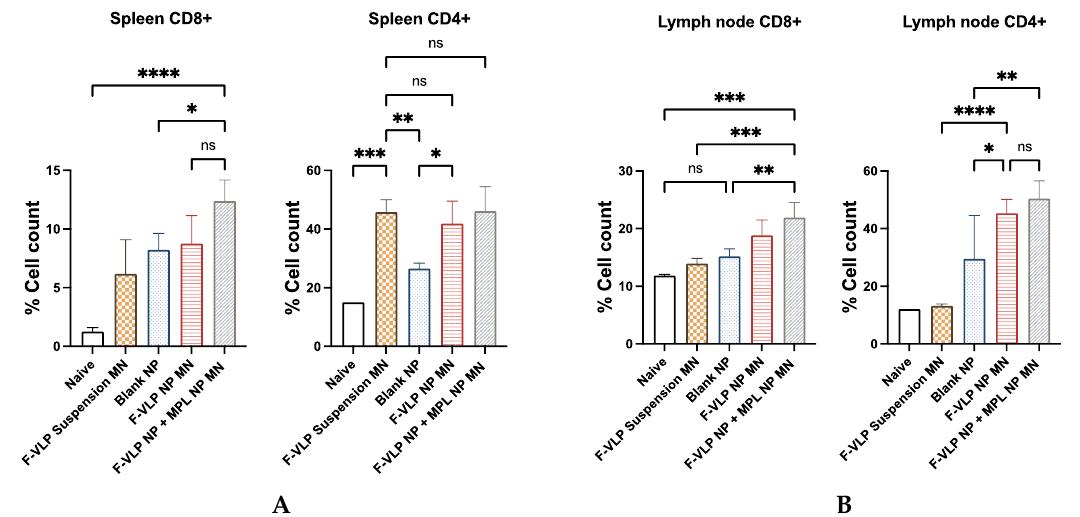
Figure 6. Immunization with intradermal adjuvanted vaccine nanoparticles generated CD8+ and CD4+ T cells: ( A ) CD8+ and CD4+ cells in lymph nodes; ( B ) CD8+ and CD4+ cells in spleen; 10,000 events/cells were acquired for each experiment. * p < 0.05, ** p < 0.01,*** p < 0.001 and **** p < 0.0001, ns: not